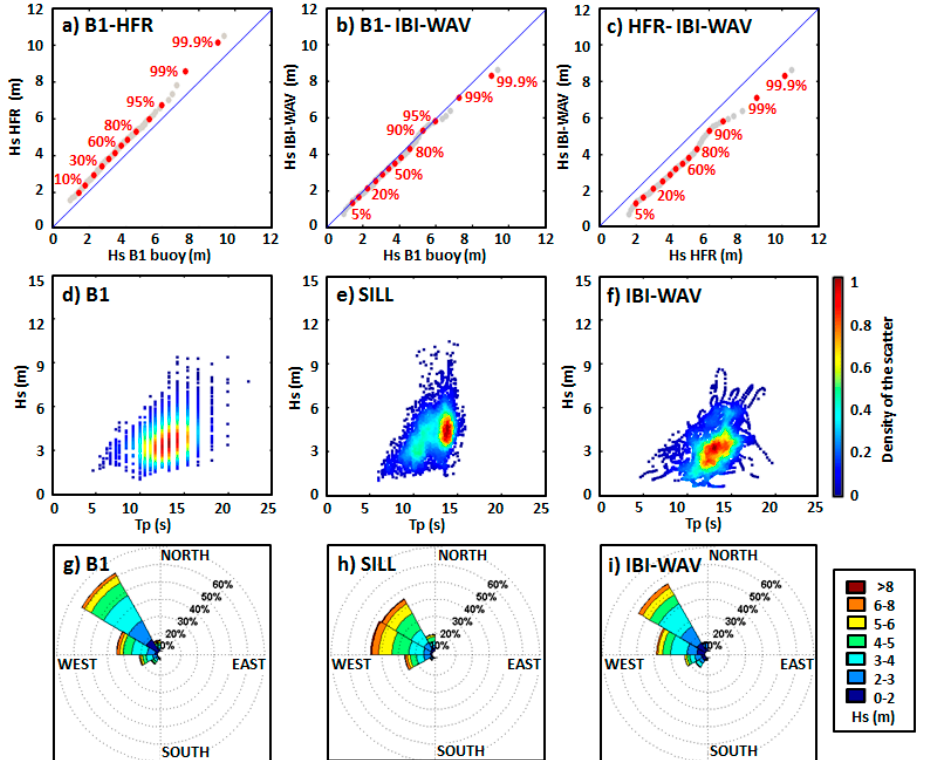
Figure 4. ( a – c ) Q-Q plots derived from the intercomparison between in situ (B1 buoy), remote sensed (SILL radar site—HFR), and modeled (IBI-WAV) Hs data for the 2015–2016 wintertime period: 5–99.9% quantiles were established (red filled dots); ( d – f ) Comparison of Hs versus Tp for each data source; ( g – i ) Comparison of the main wave directions registered at the B1 buoy, SILL radar site, and IBI-WAV in the closest grid point, respectively.